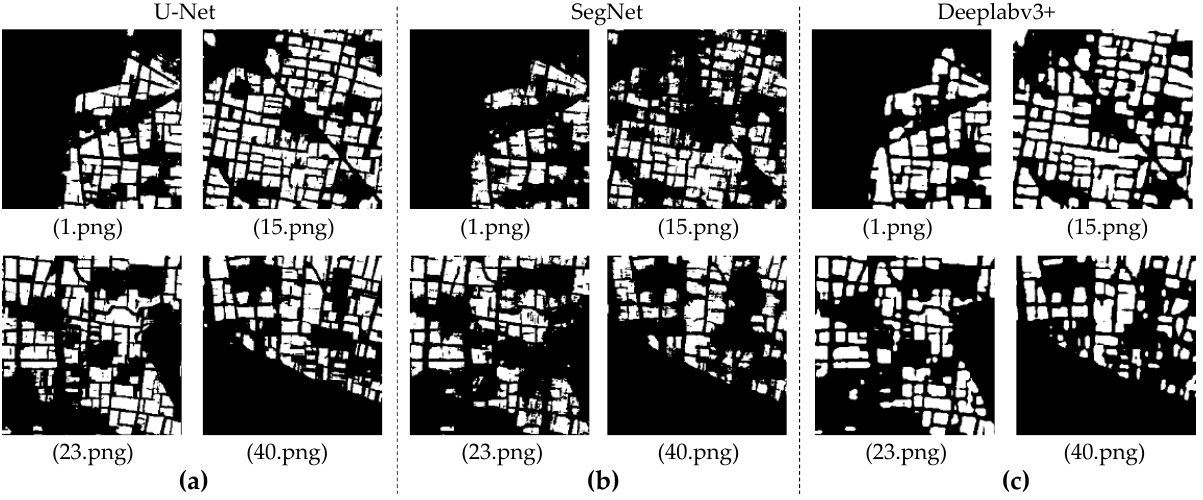
Figure 12. Comparison of identified soybean planting areas using the three models: ( a ) U-Net, ( b ) SegNet, ( c ) DeepLabv3+.